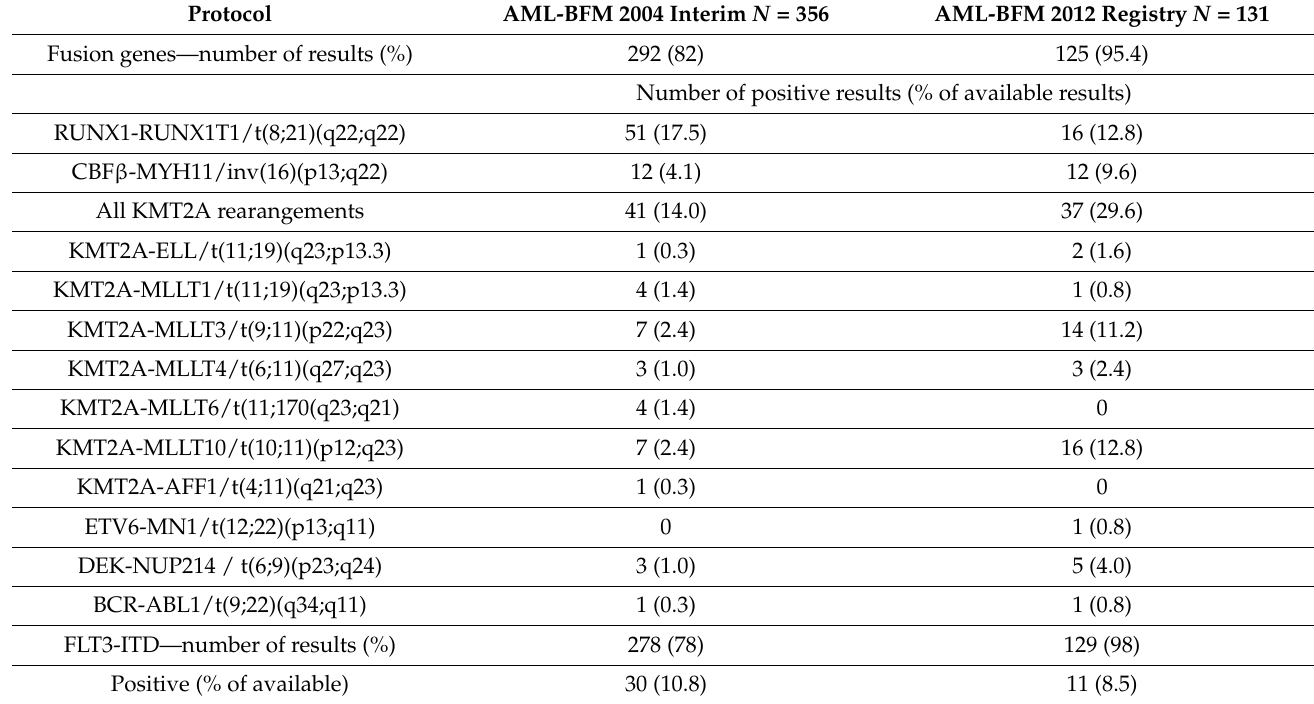
Table 5. Cytogenetics and molecular